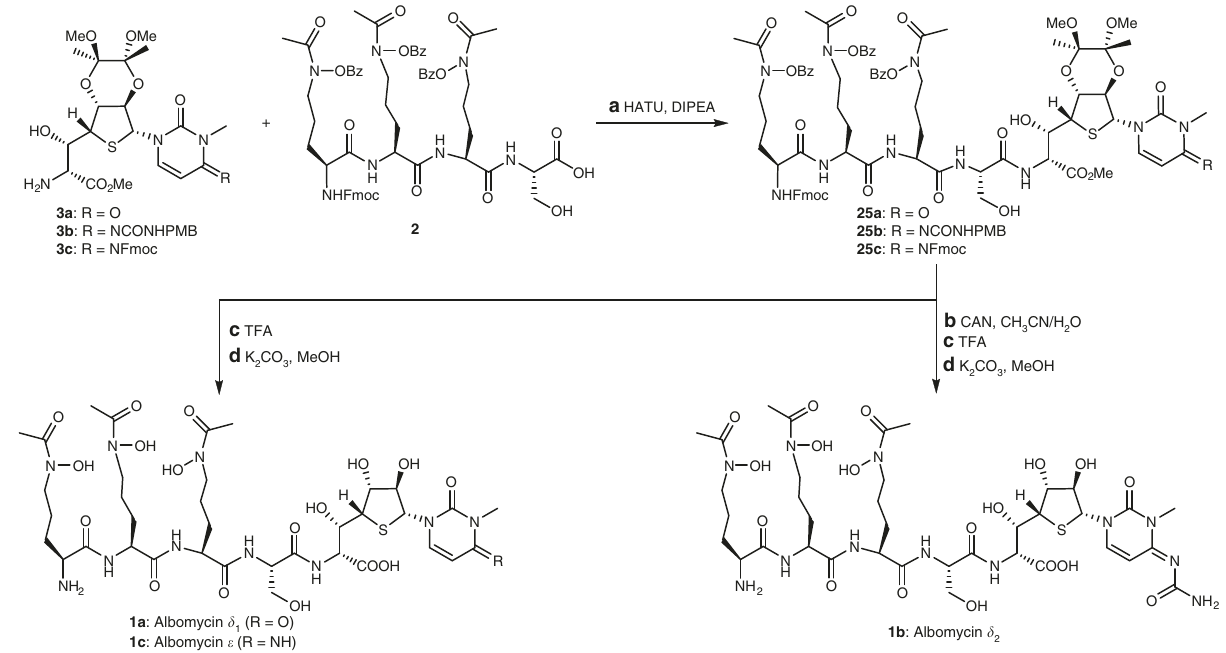
Fig. 5 Total synthesis of albomycins δ 1 , δ 2 , and ε . Reagents and conditions: a HATU (1.5 equiv), DIPEA (2.0 equiv), DMF, − 15 °C, 2 h, 25a : 93%, 25b : 91%, 25c : 90%; b CAN (10.0 equiv), CH 3 CN/H 2 O, 30 min; c TFA, H 2 O, 1 h; d K 2 CO 3 , MeOH, H 2 O, 1a : 80% (over 2 steps), 1b : 72% (over 3 steps), 1c :